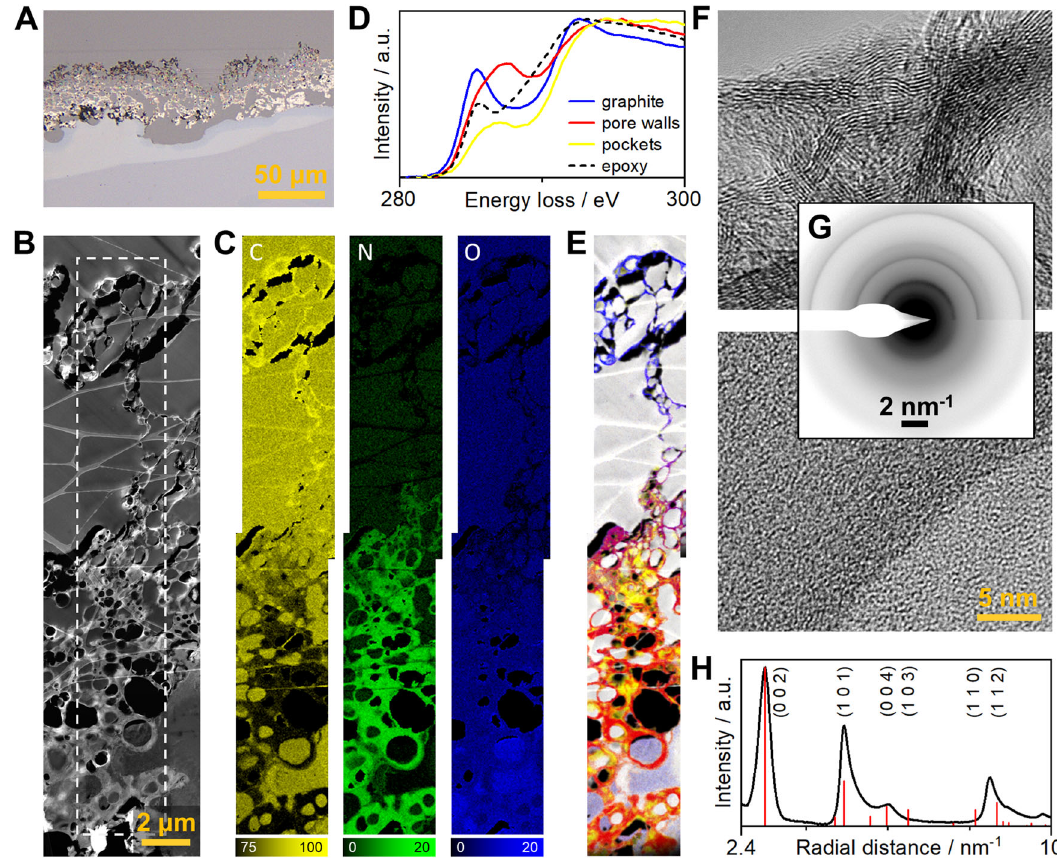
Fig. 4 Cross-sectional chemical and structural analysis of fl exible LP-C sensor strips. A Optical micrograph of the resin in fi ltrated LP-C fi lm. B Cross-sectional high-angle annular dark- fi eld (HAADF)-STEM overview of LP-C fi lm (PET substrate on bottom cropped, some pores appear black due to insuf fi cient in fi ltration, web of Lacey TEM support fi lm superimposed, epoxy at constant gray value). C EELS elemental maps of C, N, and O taken from the dashed area in ( A ) (concentrations given in at% without hydrogen). D Bonding analysis of the same region (blue: pure graphitic carbon, red: amorphous pore walls, yellow: pockets, white/black: resin). E EELS fi tting parameters visualizing the distributions of the four components. F Representative HRTEM images from the upper and lower fi lm regions. G Representative selected-area electron diffraction (SAED) patterns from the upper and lower regions of the LP-C fi lm where the atomic-resolution micrographs were recorded. H Radial intensity scan from SAED pattern of the upper region of the LP-C fi lm as shown in ( F ) (black) and simulated graphitic carbon